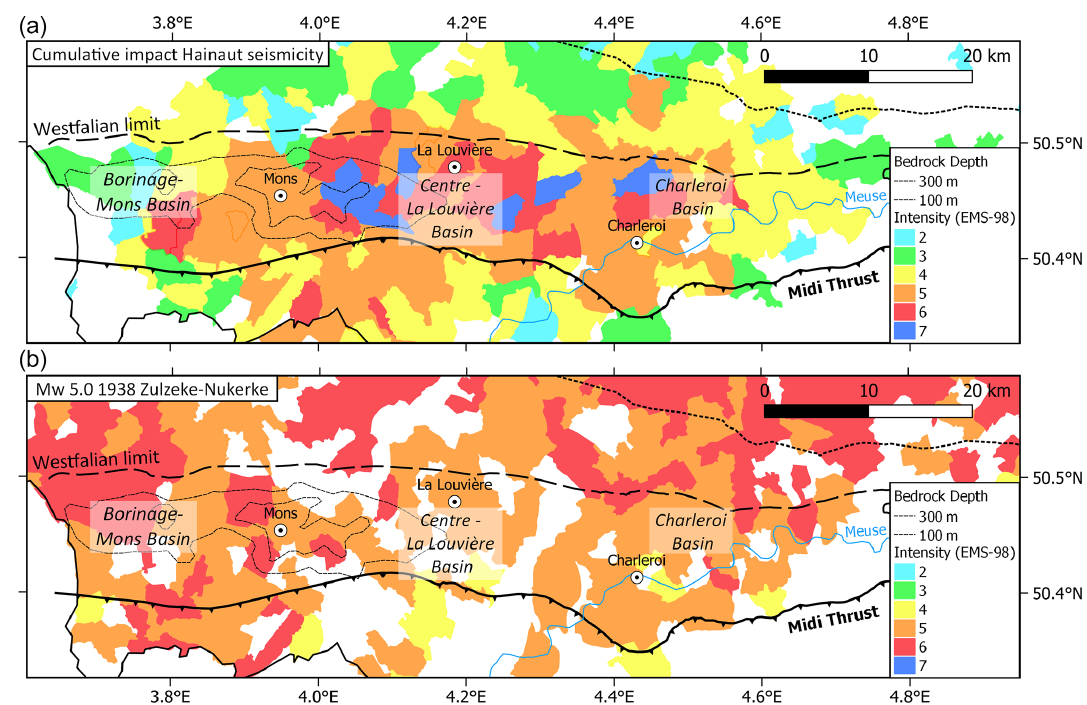
Figure 10. (a) Communal map of the Hainaut coal area showing the maximum intensities that were reached by the 124 earthquakes. (b) For comparison, the impact of the 1938 earthquake on the Hainaut coal area is shown. This earthquake had a larger impact on the Brabant Massif and in the western part of the Mons basin but not on the Centre-La Louvière or Charleroi